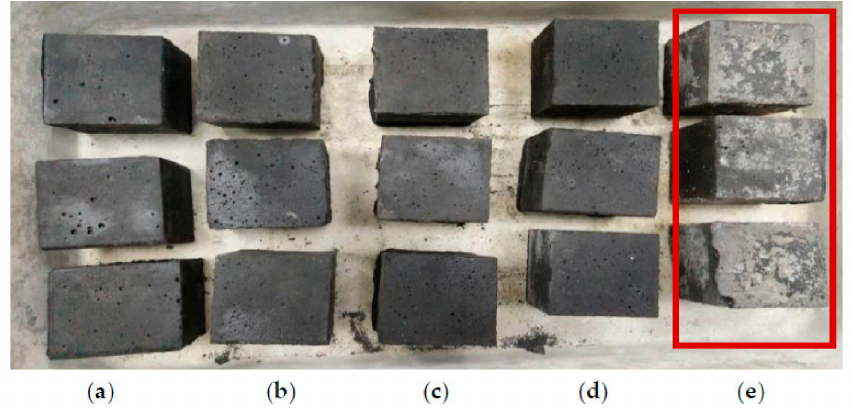
Figure 10. Appearance of alkali-activated POFA geopolymer at alkaline activator ratios of ( a ) 3.0, ( b ) 2.5, ( c ) 2.0, ( d ) 1.5, and ( e ) 1.0.